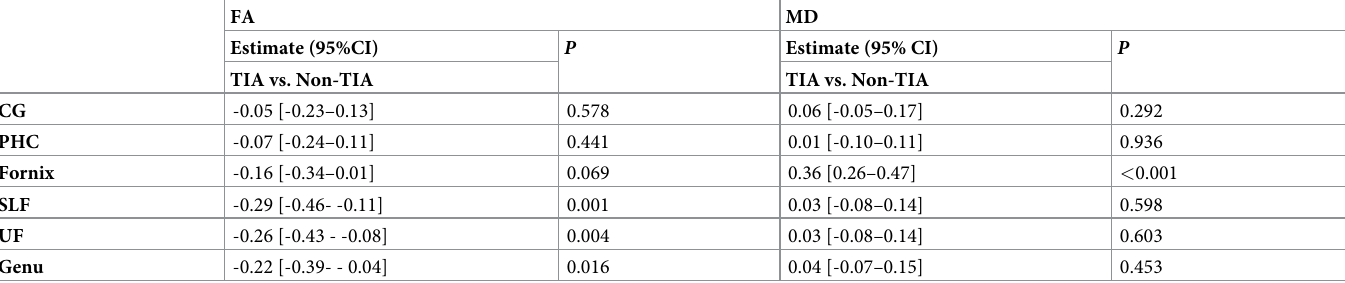
Table 3. Linear mixed-effects regression analysis for FA and MD controlling for age, sex, premorbid intellect, Framingham Risk Score (FRS), intracranial volume (ICV), WM hyperintensities volume, and the interaction of FA and MD with group (TIA subjects and non-TIA subjects).